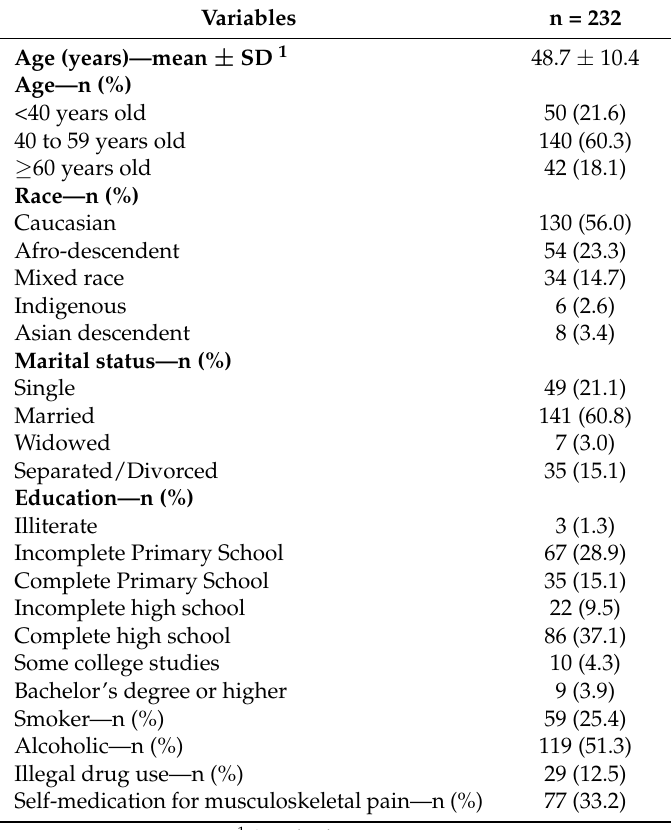
Table 1. Sample’s characterization (n =